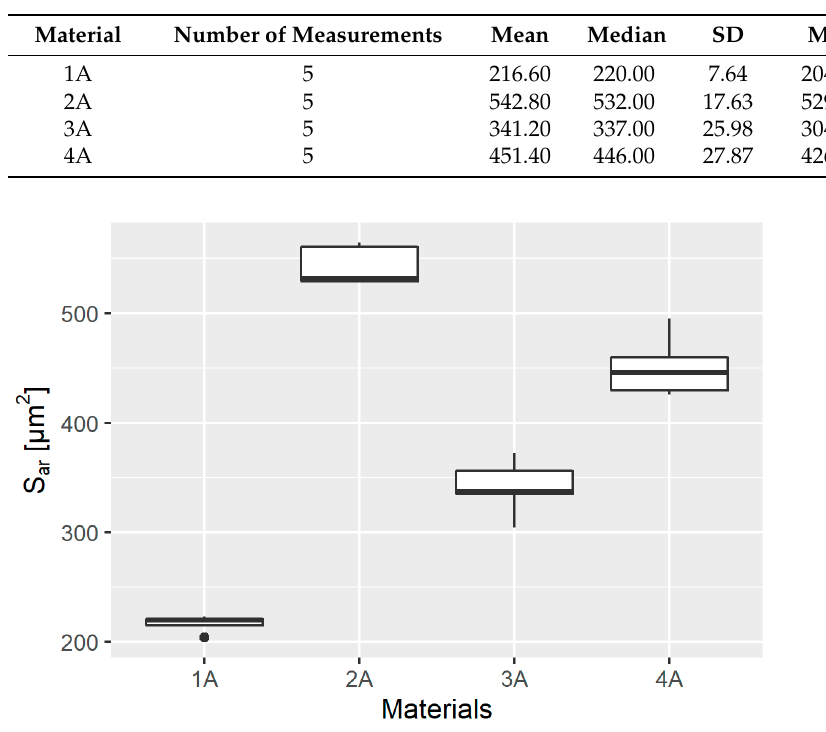
Figure 11. Box plot of measurement of the cross-sectional area of S ar scratches based on the measurements made using the optical profilometer in individual material groups.